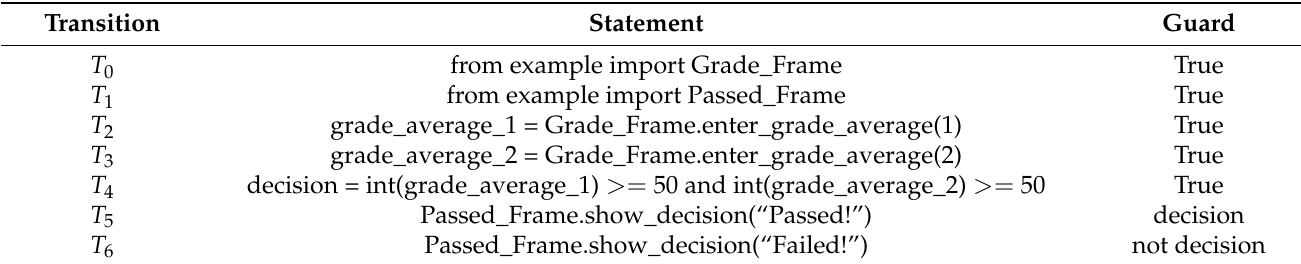
Table 2. Statements and guards of the grading example